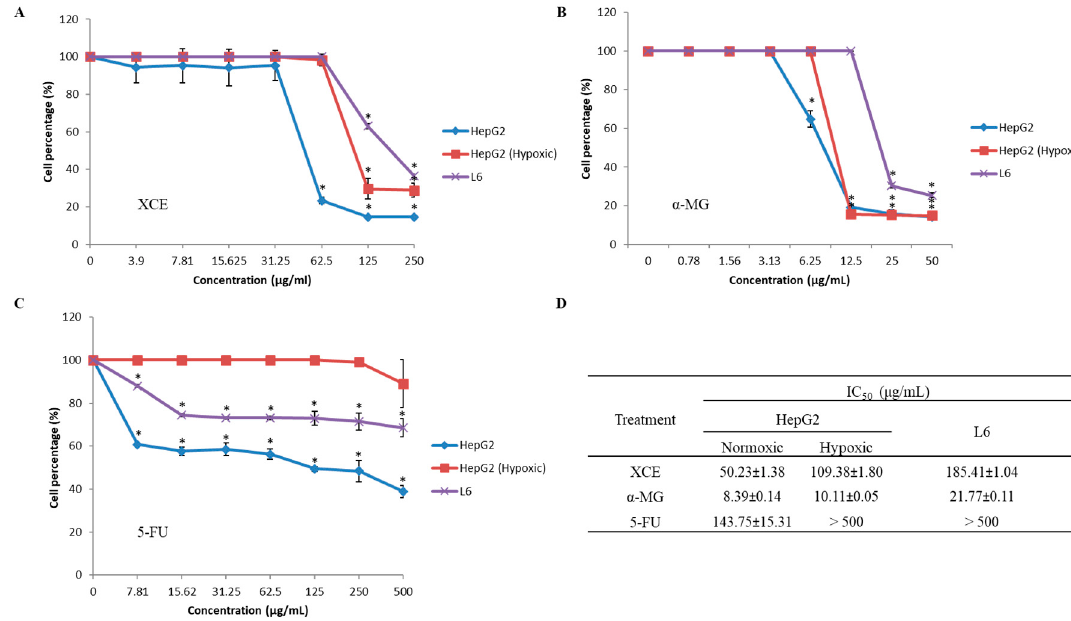
Figure 3. The cytotoxic effect of ( A ) XCE, ( B ) α -MG, and ( C ) 5-FU on HepG2 (both hypoxic and normoxic conditions) and L6 cell lines. ( D ) Cells were treated with a series of concentrations to obtain half maximal inhibitory concentration (IC 50 ) of the treatment compound against cell survivability. All experiments were repeated thrice with five technical replicates. Error bars showed the SEM. Asterisk (*) showed the significant ( p < 0.05) difference between cell groups at each concentration. Experiments were analyzed using single ANOVA.